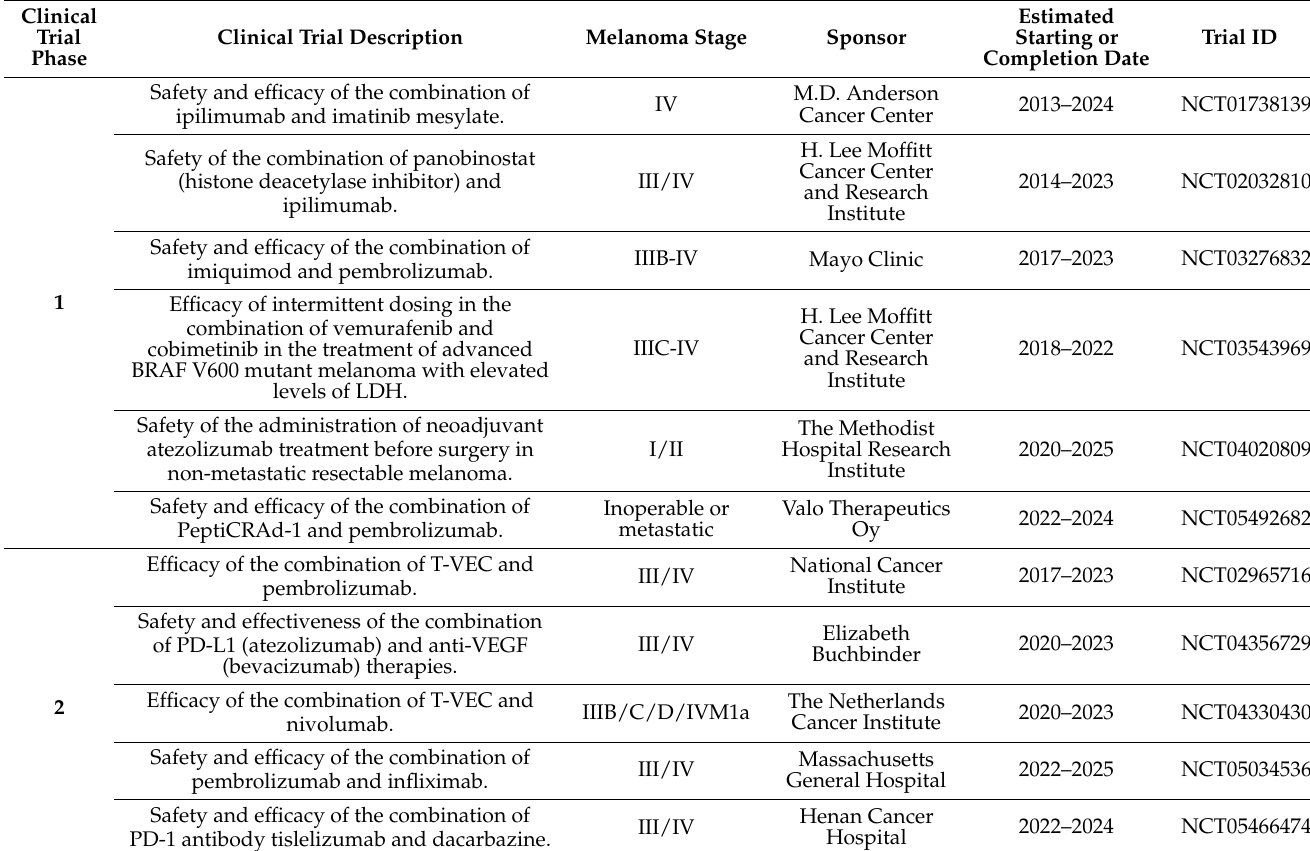
Table 4. Examples of melanoma treatments undergoing clinical